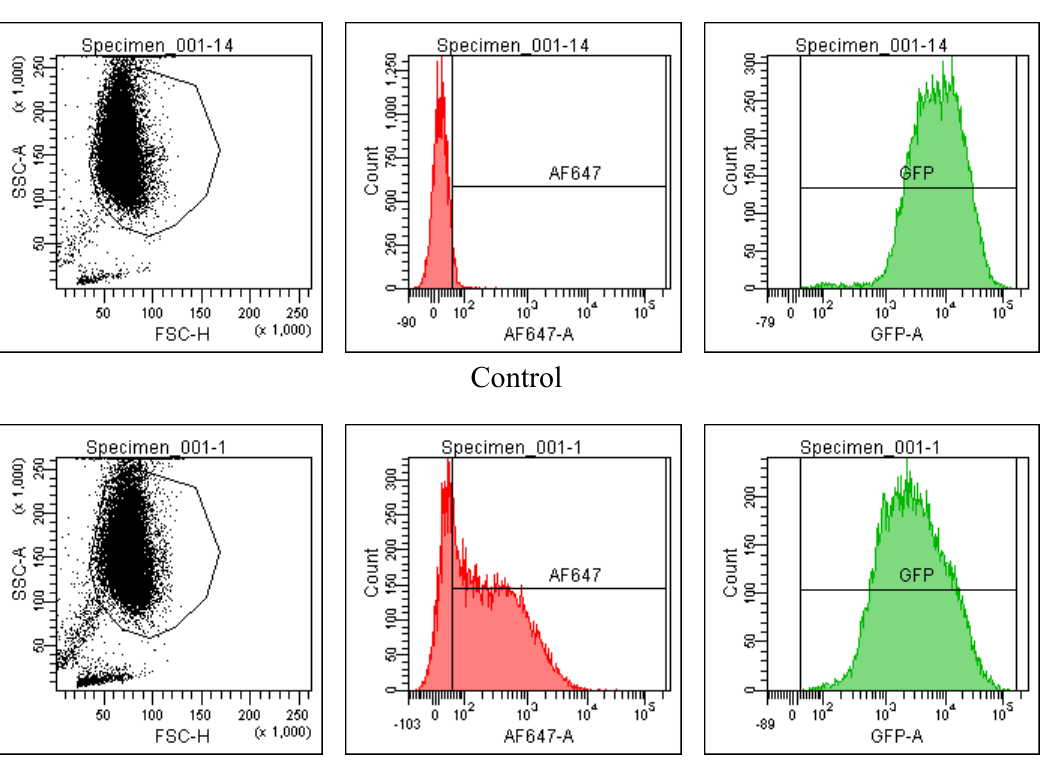
Figure 6. Gated FACS analysis of delivery of siRNA (15 nM, 15 pmol/well) against GFP (labelled with Alexa Fluor® 647 at the 3'-position of the sense strand) and GFP expression in HeLa cells 48 h post transfection with lipoplexes of 3 and 4 (6 µg/well) at an siRNA concentration of 15 pmol/well. The AF647 gate (red) shows 75% of parent-gated cells with 3 , and 92% of parent-gated cells with 4 . The GFP gate (green) shows silencing to ~40% and ~25% respectively measured by geometric mean fluorescence relative to control (top